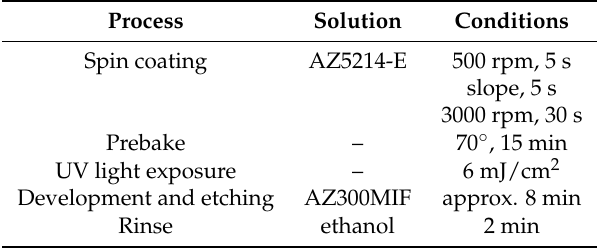
Table 1. Fabrication conditions for patterned